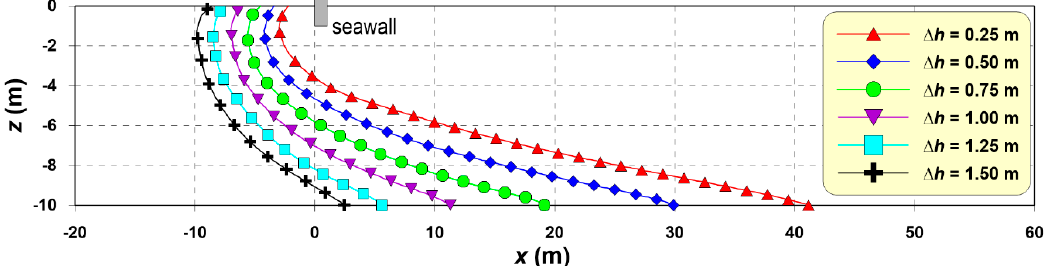
Figure 13. Equilibrium interfaces between seawater and freshwater due to differences in water levels.